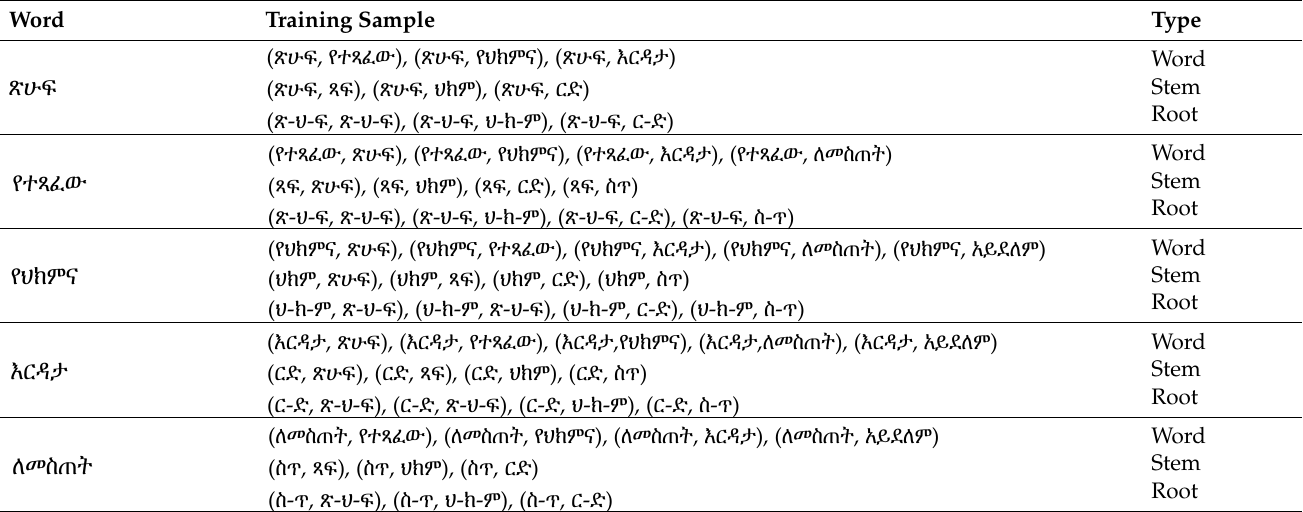
Table 1 . Word-based, stem-based, and root-based Skip-gram training samples of word2vec. The first column contains the target/input in surface word form before morphological analysis, whereas the second column contains pairs of target and context/output words for word-based, stem-based, and root-based approaches of the given word.